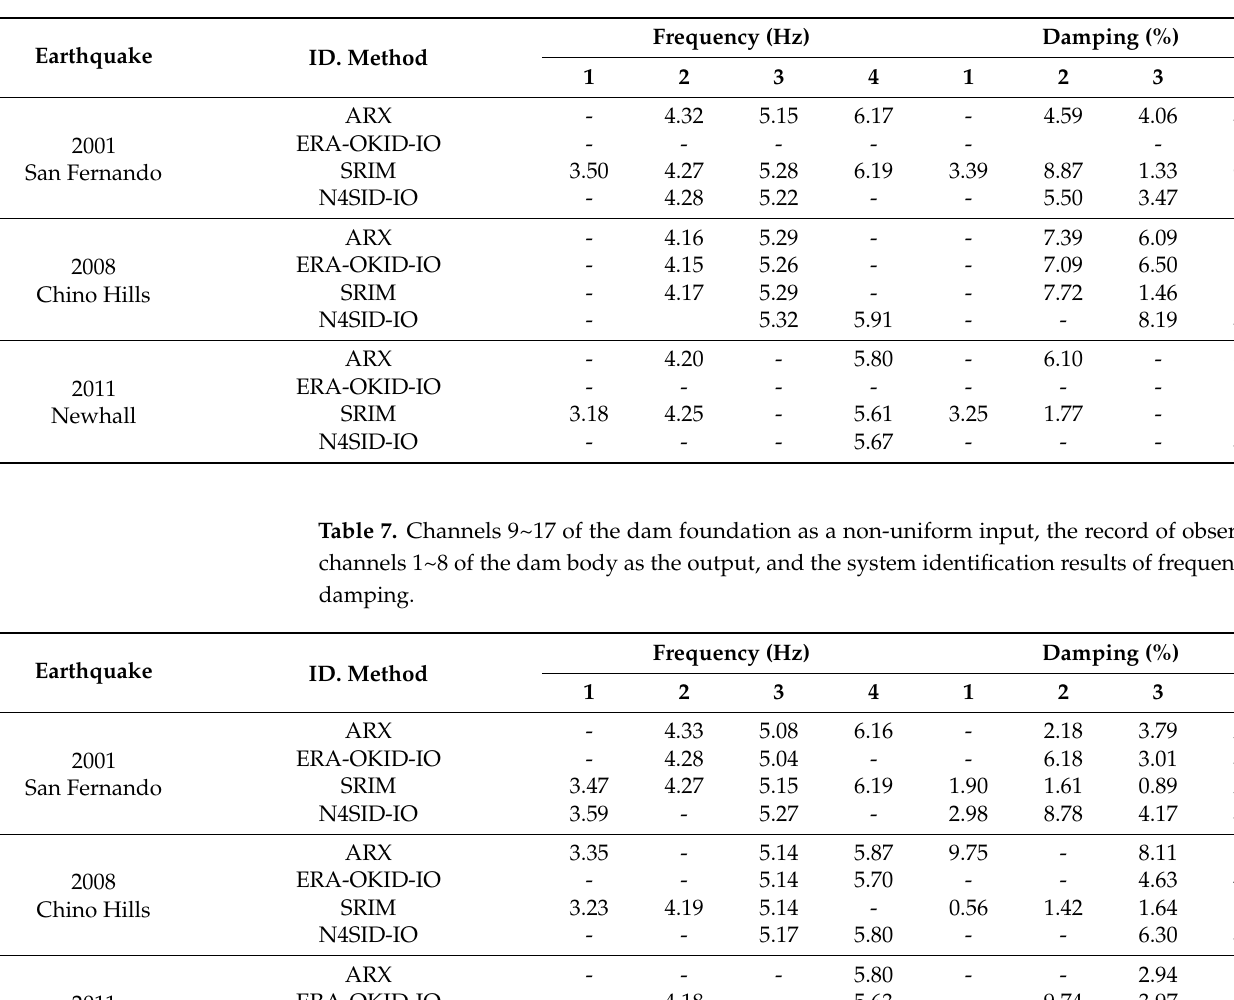
Table 6. Record of observation channels 9, 12, and 15 of the dam foundation following the river as a uniform input; record of observation channels 1, 2, 5, 6, 7, and 8 of the dam body following the river as the output; and the system identification results of frequency and damping.